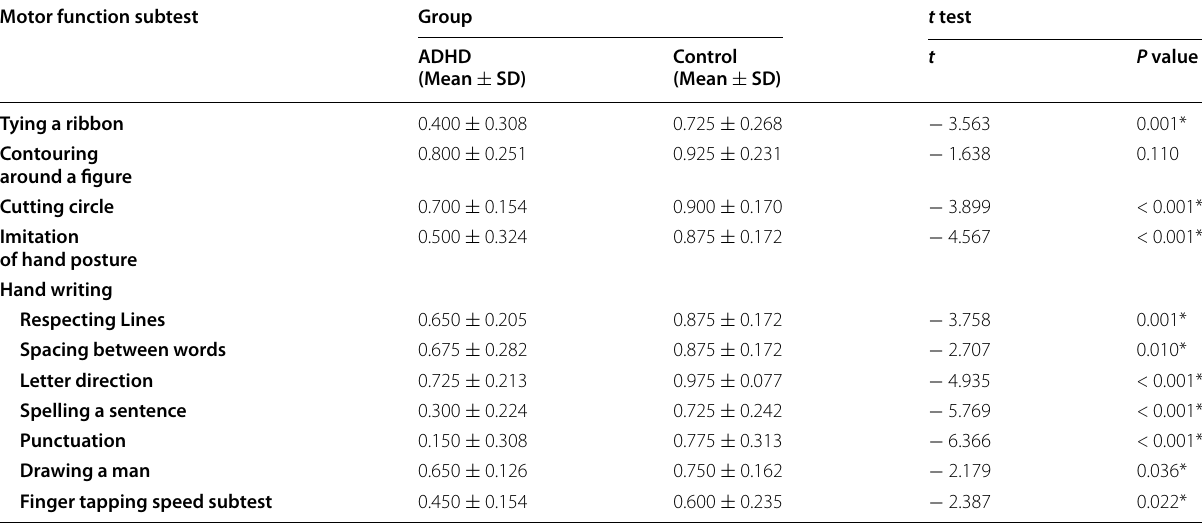
Table 5 Comparison between ADHD and control children results regarding scoring of DDS, fine motor function, and proprioceptive function